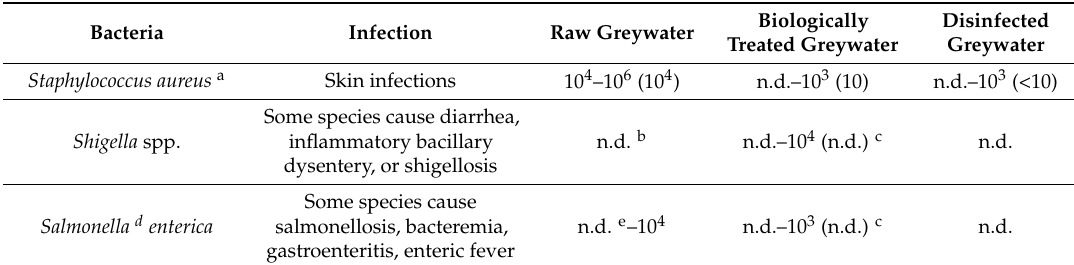
Table 1. Ranges of concentrations (cfu/100 mL) of selected pathogens in raw, biologically treated, and disinfected greywater. Values in parentheses represents mean order of